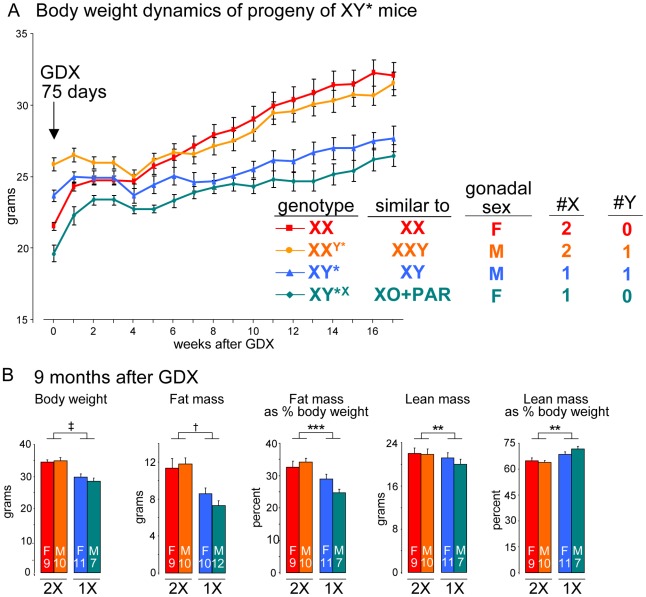
The number of X chromosomes determines differences in body weight and adiposity.(A) Body weight following gonadectomy at day 75 of mice having the indicated sex chromosome complements fed a chow diet. The Y* chromosome has been described [41], and the near equivalent genotype in terms of X and Y chromosome complement is shown. Two groups of mice with two X chromosomes had higher body weight, relative to mice with one X chromosome, beginning at 8 weeks after GDX and thereafter (p<0.000001). Mice with a Y chromosome did not differ from mice lacking a Y chromosome. (B) Body weight and body composition determined by NMR in mice shown in panel (A) at 9 months after GDX. Values shown for all bars represent mean ± SEM for the number of each genotype indicated. **, p<0.01; ***, p<0.001; †, p<0.0001; ‡, p<0.000001.